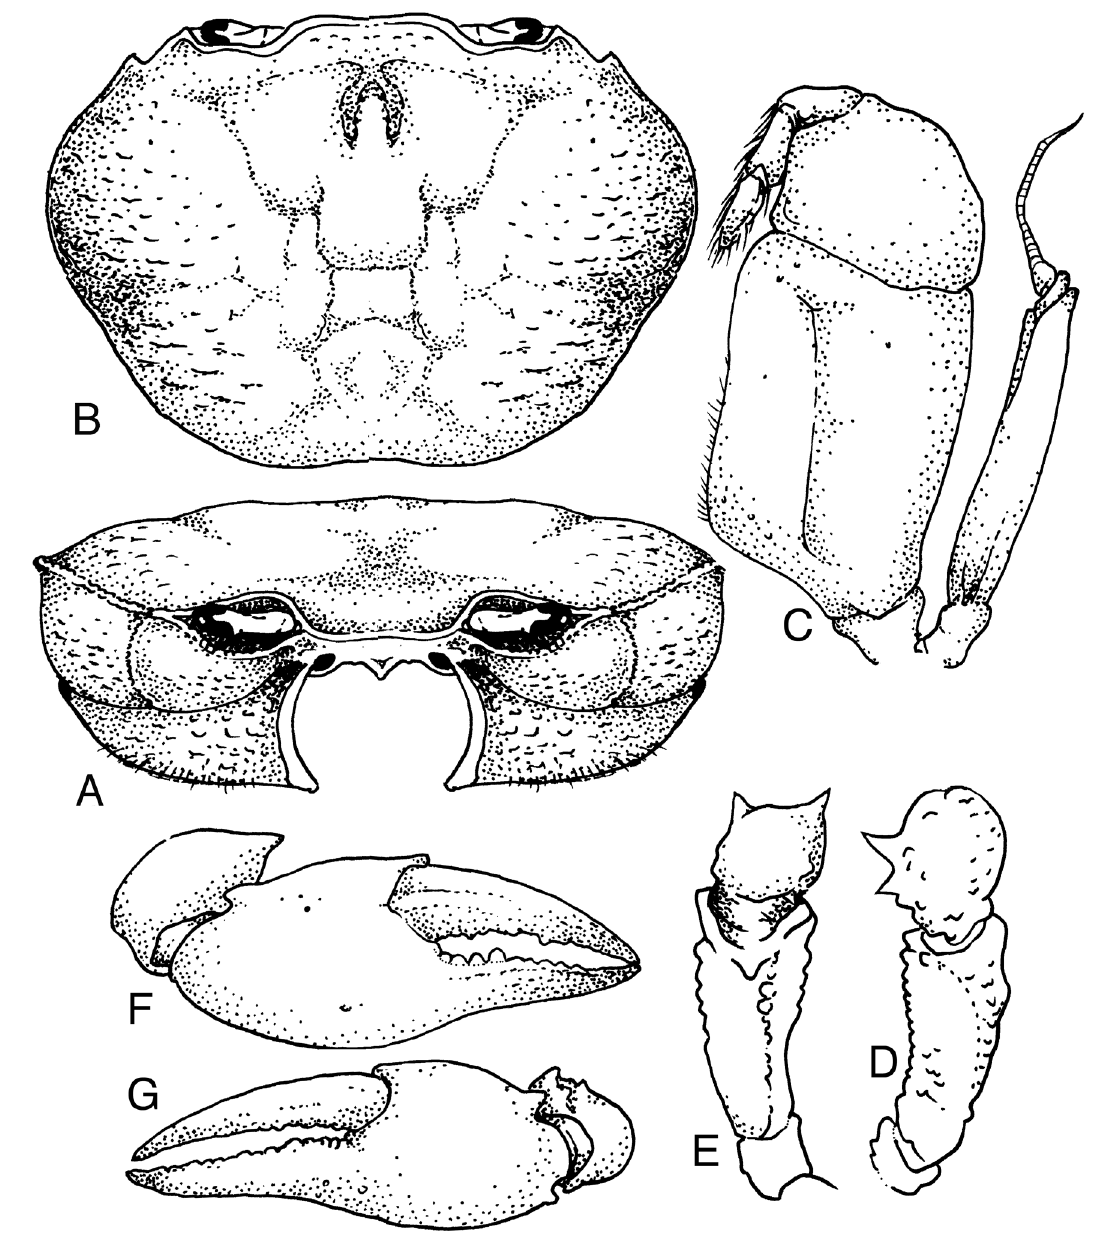
Fig. 1. Foza manonae sp. nov. Holotype, adult ♂, CW 43.7 mm, Ankarana Special Reserve, Madagascar (ZSM A20145003). A . Carapace, frontal view. B . Carapace, dorsal view. C . Third maxilliped, ventral view. D . Carpus and merus of cheliped, dorsal view. E . Carpus and merus of cheliped, ventral view. F . Right cheliped, frontal view. G . Left cheliped, frontal